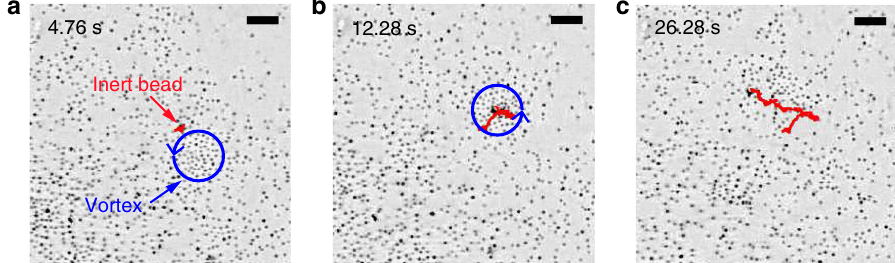
Fig. 4 Inert bead capture and transport by a roller vortex. a – c The snapshots demonstrate the capture and transport of a passive glass bead ( d bead = 500 ± 25 μ m). See also Supplementary Movie 2. The red curve marks the path traveled by the passive bead and the blue circle encloses the particles that are a part of the vortex. The arrow denotes the direction of the vortex rotation. b the scatterer is captured by the vortex through intermittent fl ocking. The passive particle is transported by the vortex for about 14 s. The vortex spontaneously disintegrates (frame c ) to release the bead. The energizing fi eld: B 0 = 6.07 mT, f B = 43 Hz. The scale bars are 2